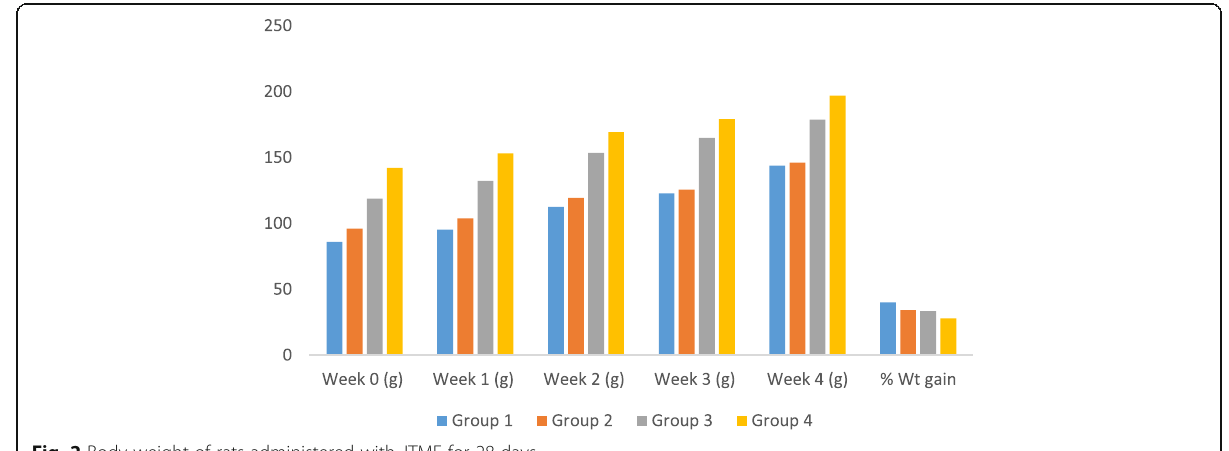
Fig. 2 Body weight of rats administered with JTME for 28 days